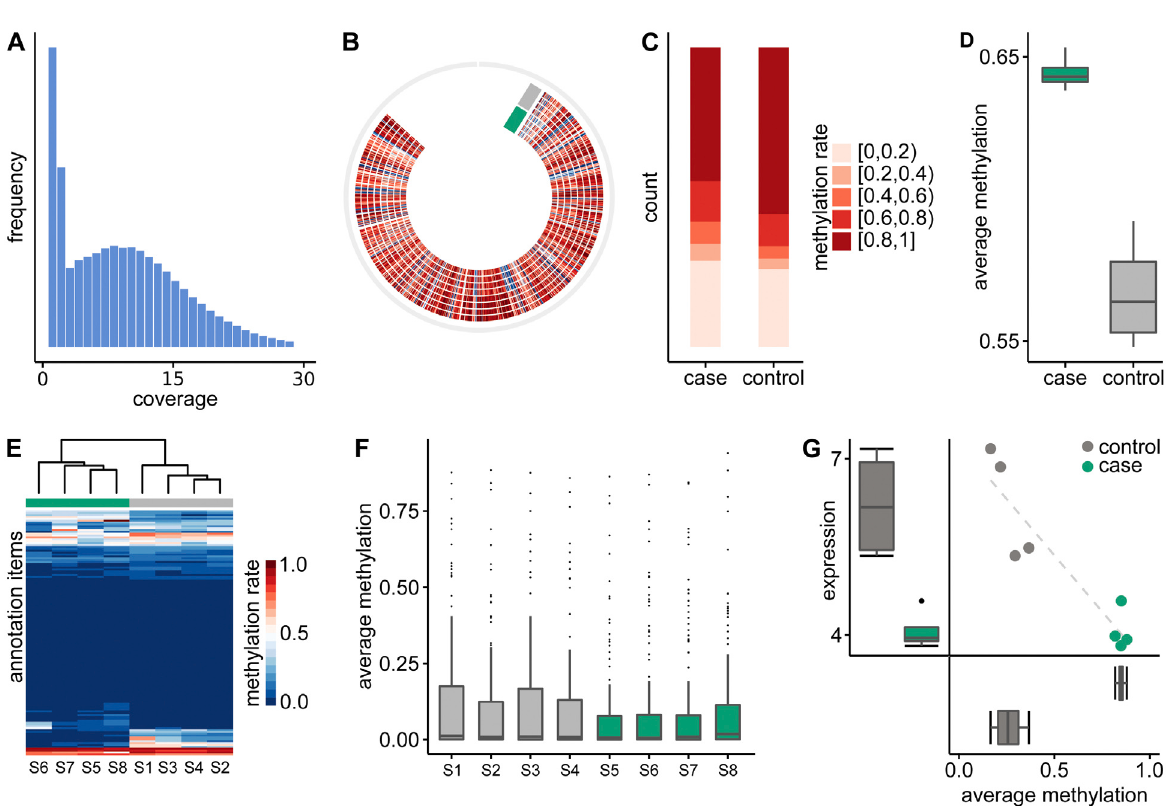
Figure 2. Selection of figures generated on-the-fly by BAT during the analysis of the example dataset. Annotation items are ENCODE transcription factor binding sites for GM12878 cell line. A ) Distribution of coverage. B ) Circos plot showing the genome-wide methylation level of eight samples as heatmap. C ) Binned distribution of average methylation rate per CpG for each group. D ) Boxplots of genome-wide mean methylation rate per group. E ) Hierarchical clustered heatmap of the methylation rates of all samples over all annotation items. F ) Boxplots of average methylation rate per annotation item. G ) Correlating DMR plot shows methylation and expression of a DMR - gene pair. Note that all figures were produced by BAT itself, but were minorly post-edited to fit the limited